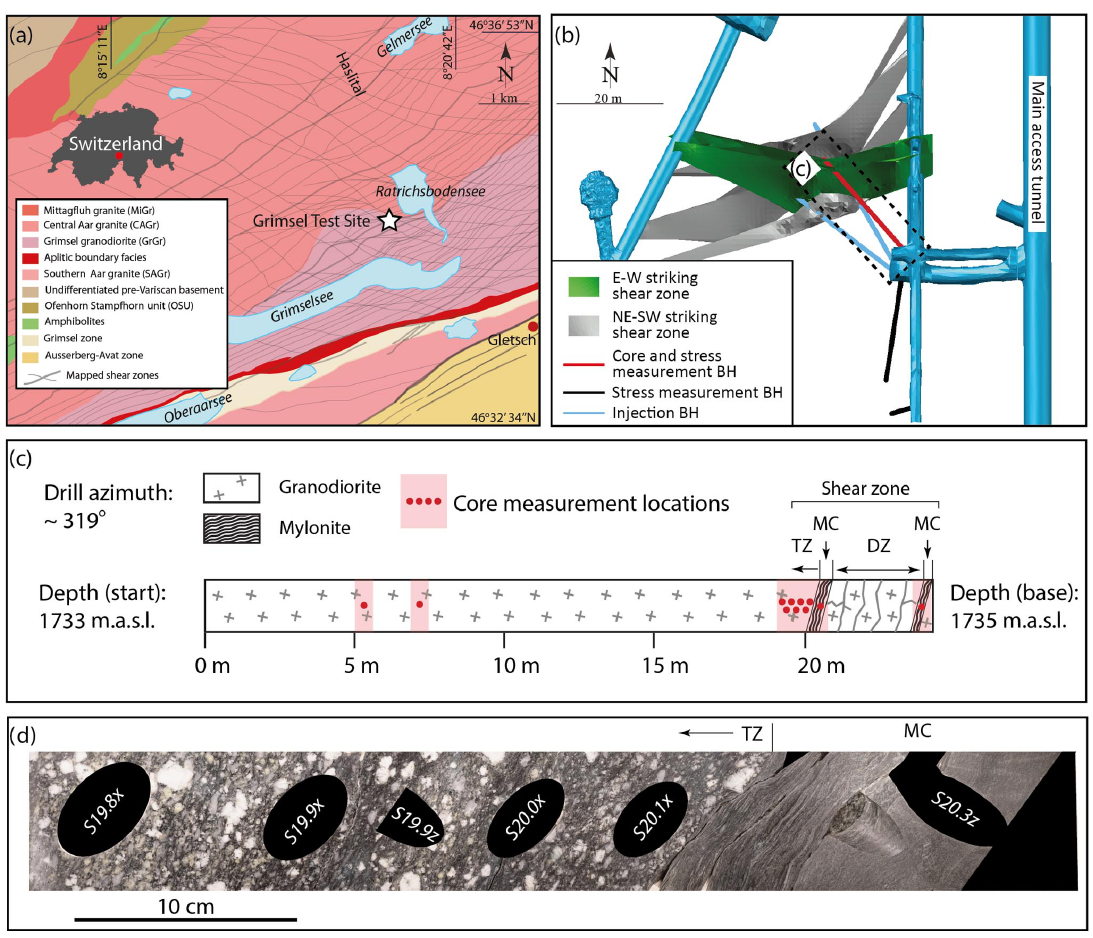
Figure 1. (a) Geologic map of the Grimsel pass region (after Wehrens et al., 2016, 2017); (b) borehole orientations (this study – red borehole) with respect to the underground research laboratory (after Krietsch et al., 2017; Amann et al., 2018); (c) the borehole in this study depicting the location of the damage zone with coring and stress measurement locations projected along the borehole. The shear zone at the base is divided into three components: (1) transition zone (TZ), (2) mylonitic core (MC), and (3) damage zone (DZ). (d) Photograph of a saw-cut cross section through part of the transition zone and the mylonitic core (black ellipses show subcored cylinders inclined to the cut